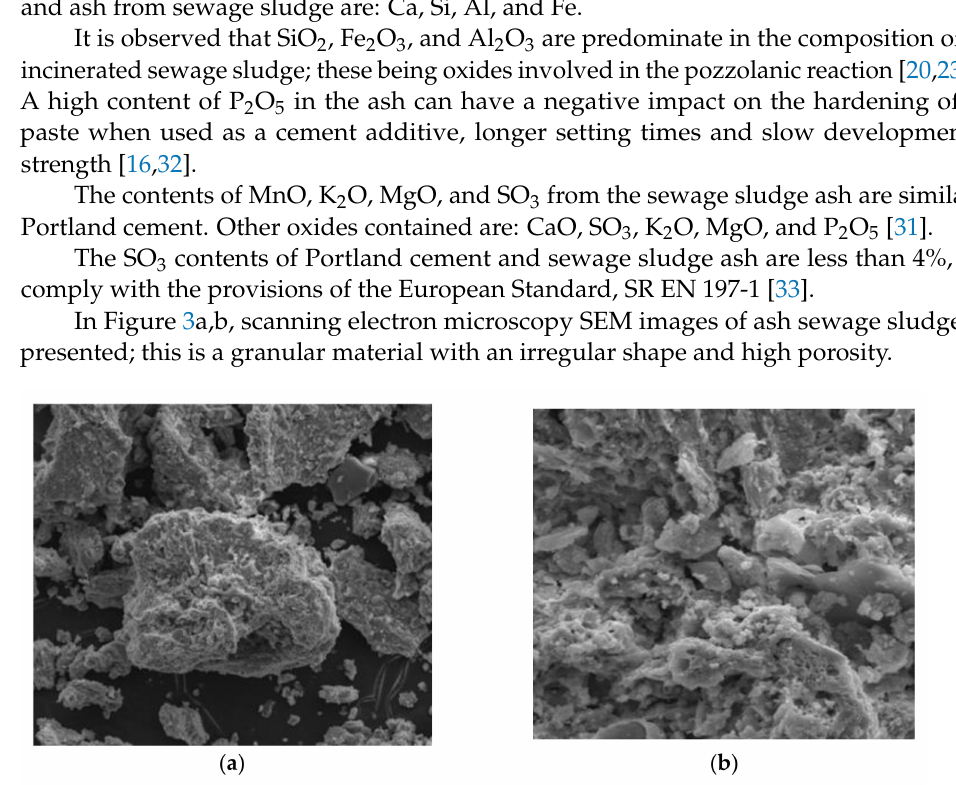
Figure 3. Images of sewage sludge ash ( a ) magnification 1000 × ( b ) magnification 4000 × by scanning electron microscopy (SEM)